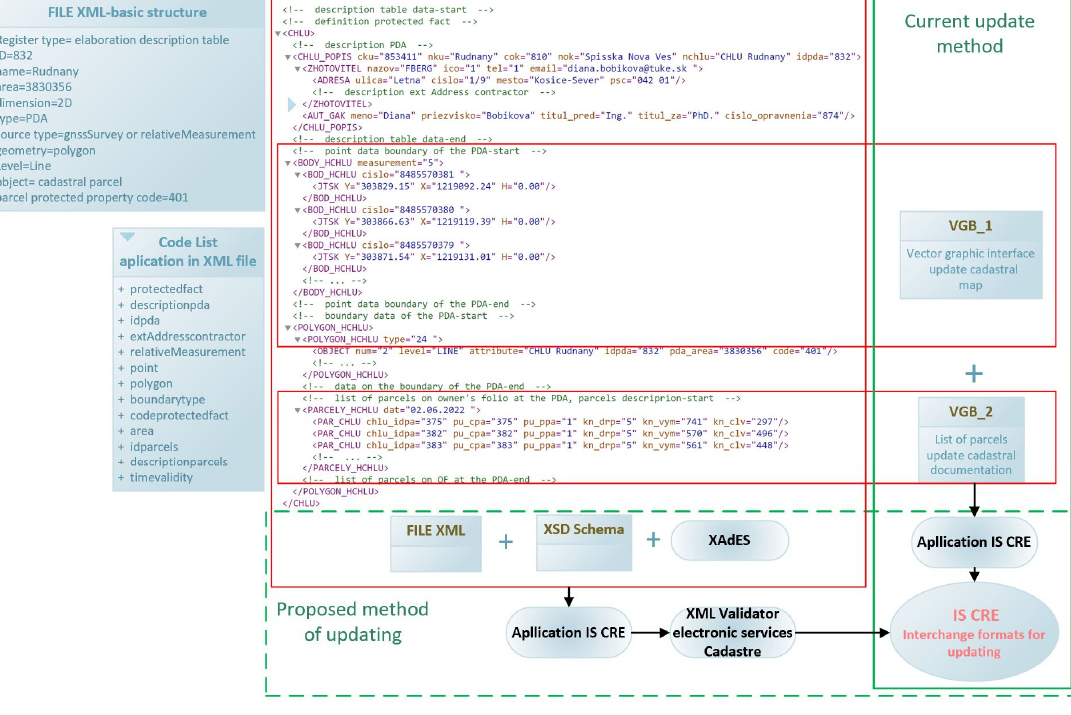
Figure 11. Representation of the proposed XML file with associated content for future update in the CRE